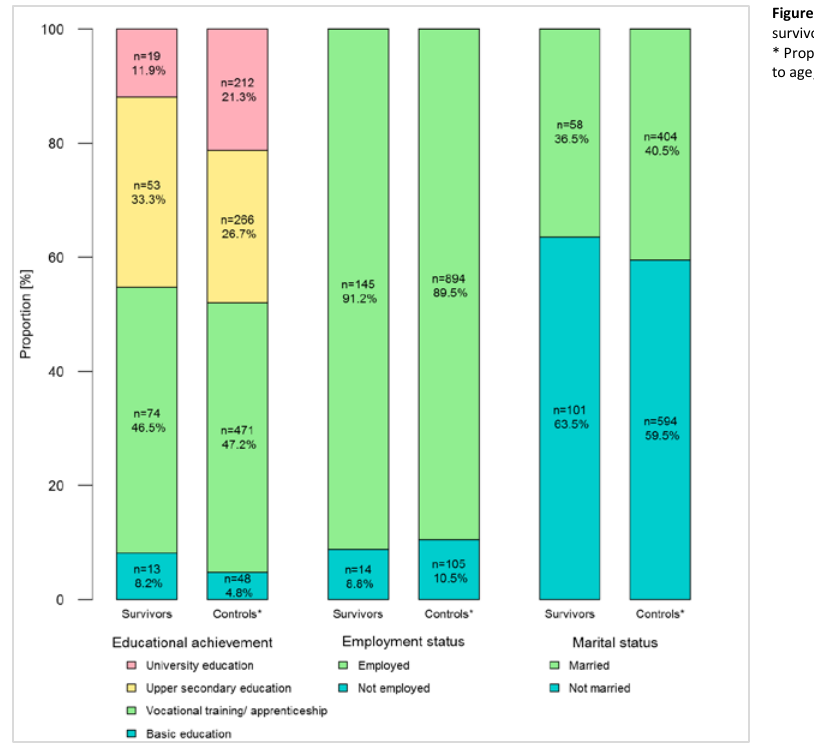
Table 2: Factors associated with educational achievement, employment status, and marital status from univariable logistic regression models (combined dataset including TYA cancer survivors and controls). Educational achievement (having basic